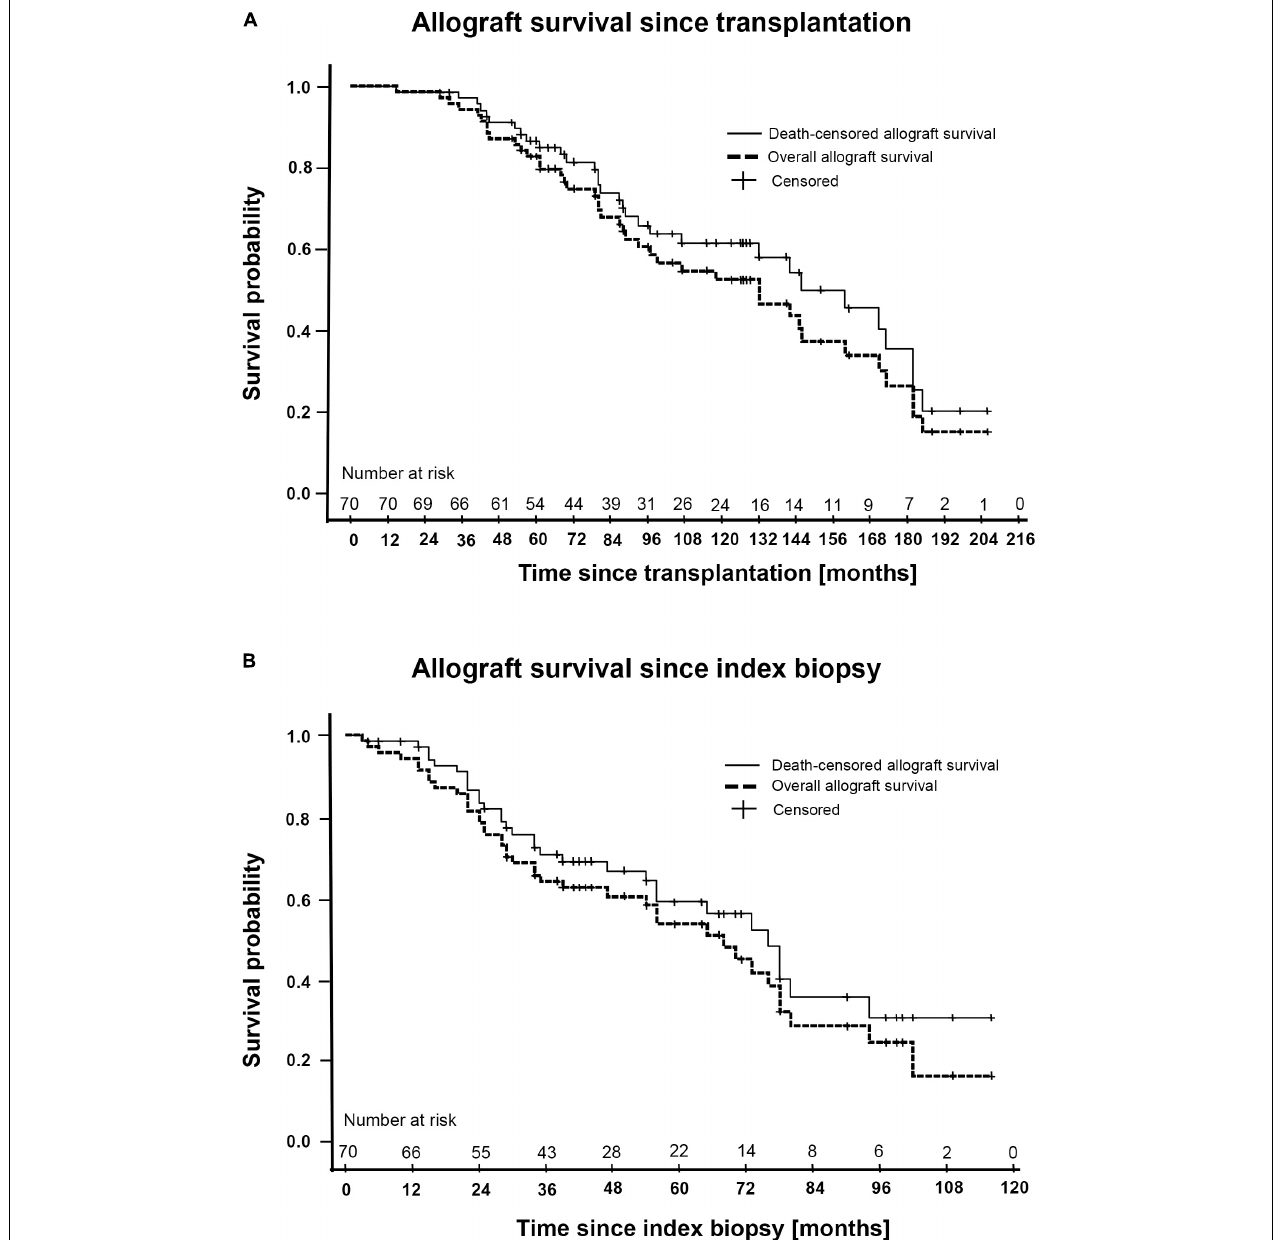
FIGURE 2 | Kaplan-Meier plots of the total cohort ( N = 70) including overall- and death-censored allograft survival since transplantation (A) and since index biopsy (B)